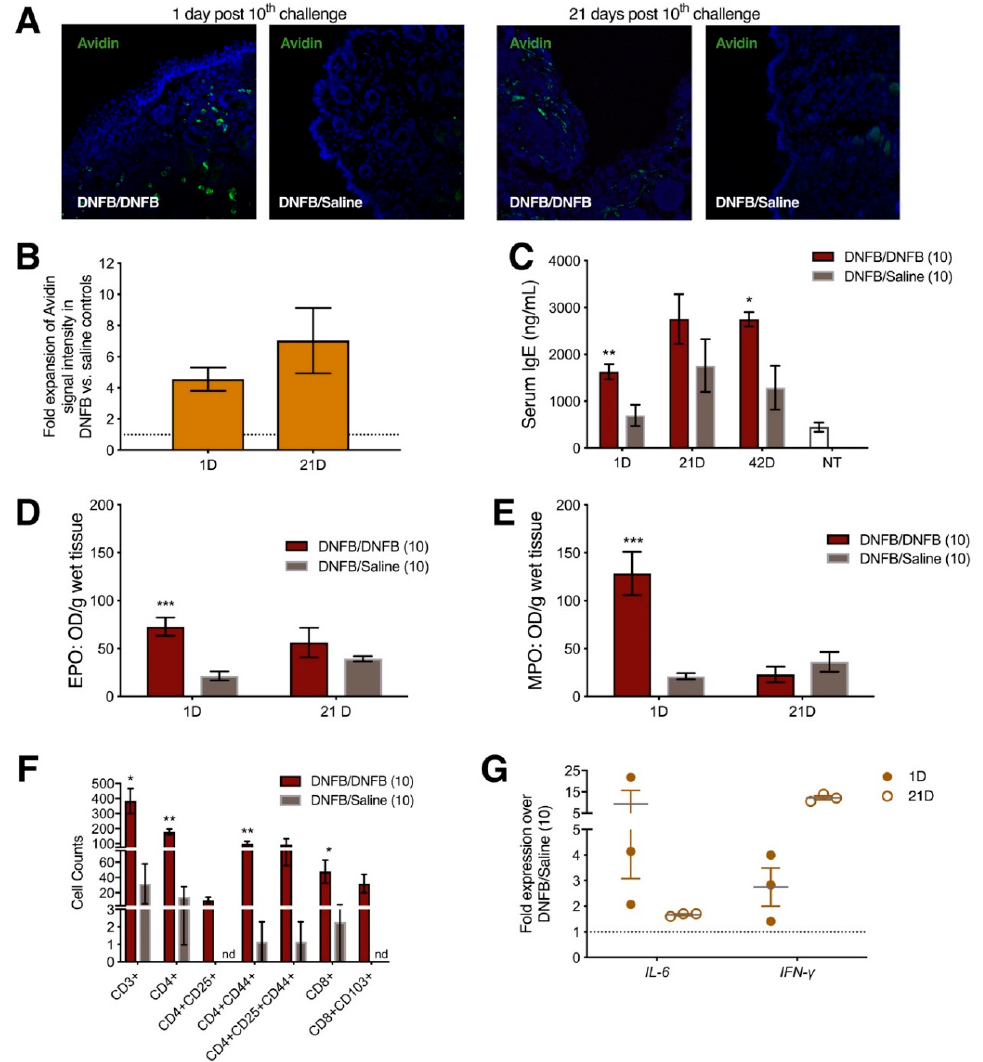
Figure 1. Repeated topical dinitrofluorobenzene (DNFB) exposure on the labiar skin in previously sensitized ND4 mice results in increased abundance of local mast cells, higher levels of IL-6 and IFN- γ transcripts, elevated serum IgE, greater myeloperoxidase and eosinophil peroxidase activity, and increased numbers of infiltrating T cells. ( A ) Representative sections at 200x magnification showing FITC (fluorescein-isothiocyanate)-Avidin-stained mast cell granules in labiar tissues of DNFB vs. saline-challenged mice 1 day and 21 days after 10 challenges; ( B ) Relative intensity of Avidin-stained mast cell granules in the labiar skin of DNFB vs. saline-challenged mice 1 day and 21 days after 10 labiar DNFB challenges. n = 3; ( C ) Total IgE levels in serum measured 1 day, 21 days, and 42 days after 10 challenges with DNFB or saline in previously sensitized mice and in age-matched untreated mice (NT). ** and * represent p -values of p < 0.01 and p < 0.05 respectively. n = 3–6; ( D ) Eosinophil peroxidase and ( E ) myeloperoxidase levels in the labiar tissue, normalized to tissue weight, 1 and 21 days after 10 DNFB or saline challenges. *** represents p -values of p < 0.001. n = 3–6; ( F ) CsD3 + , CD4 + , CD4 + CD25 + , CD4 + CD44 + , CD4 + CD25 + CD44 + , CD8 + , and CD8 + CD103 + cell numbers in flank tissues derived from previously sensitized mice challenged with either DNFB or saline vehicle on the flank. ** and * represent p -values of p < 0.01 and p < 0.05 respectively. n = 6; nd = not detected; ( G ) Relative abundances of IL-6 and IFN- γ mRNAs in the labiar tissue of DNFB- vs. saline-challenged, previously sensitized mice 1 day and 21 days after 10 DNFB challenges, each normalized to β 2-microglobulin (housekeeping) mRNA levels. n = 3.